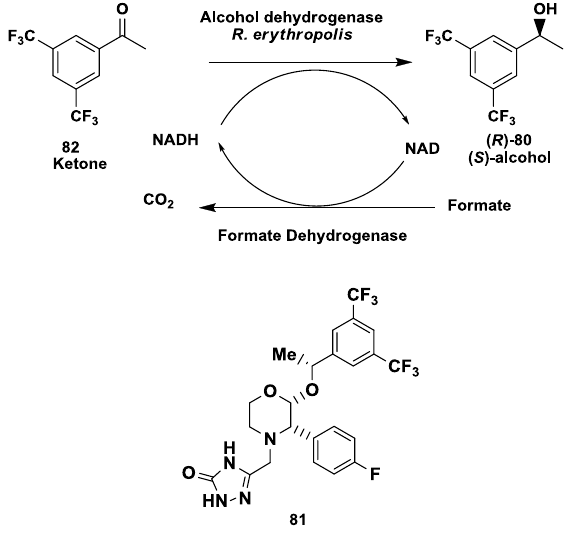
Figure 20. NK1 receptor antagonists: Enzymatic synthesis of ( S )-3,5-bistrifluoromethylphenyl